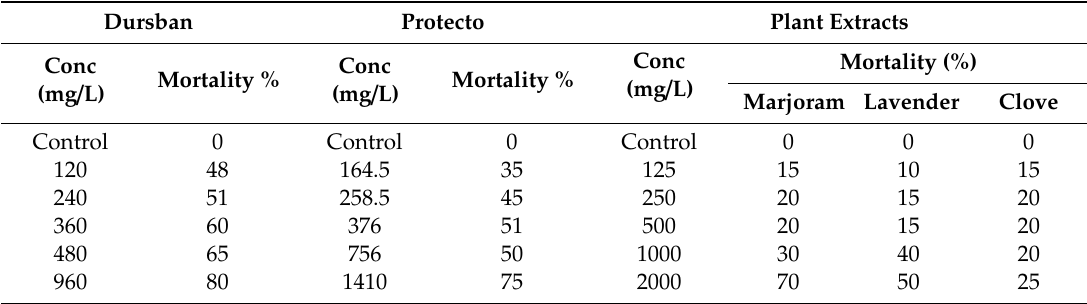
Table 5. E ff ect of various compounds on the mortality of the termite Microcerotermes eugnathus (soldiers / workers and Nymphs) in a no-choice laboratory